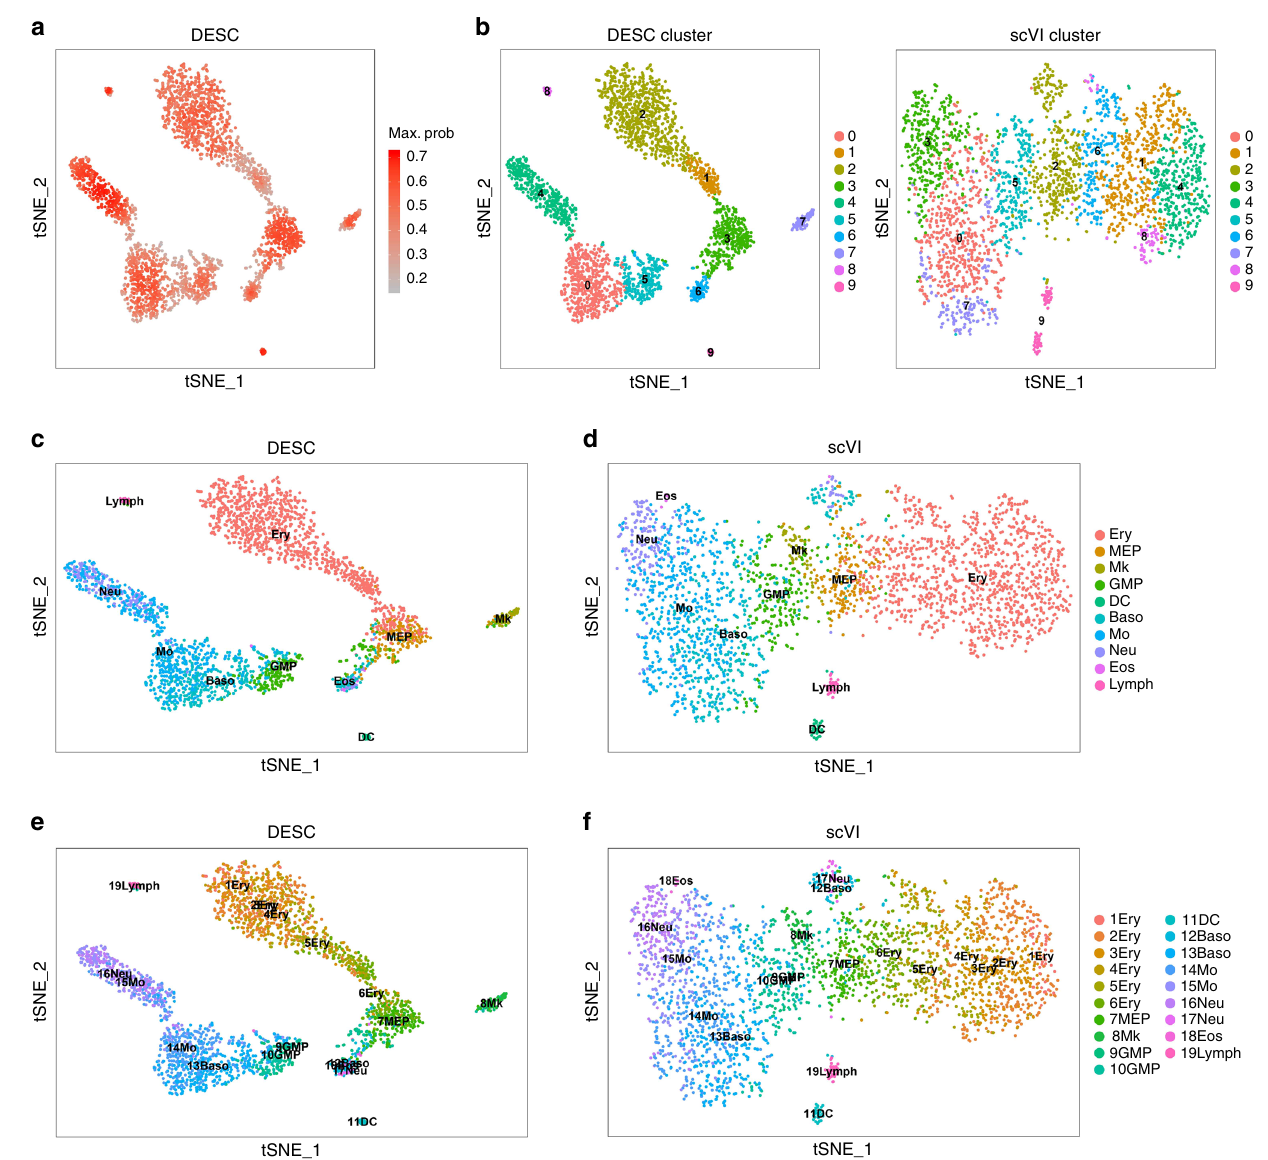
Fig. 6 The results of mouse bone marrow data generated by Paul et al. 21 . a The t-SNE plot showing the maximum probabilities of cluster assignments of cells. The maximum probability is the probability for the cluster that is assigned with the highest probability by DESC. b The t-SNE plots of clustering results by DESC and scVI. Compared with scVI, DESC yields more accurate clustering result for DC, lymph, and Mk. In scVI, the clustering result is more diffused, and Mk cells are mixed together with GMP cells. In contrast, DESC clearly separated DC, Lymph, and Mk cells from the other cell clusters. c , d The t-SNE plots of true cell-type labels (obtained from the original publication) for DESC and scVI. e , f The t-SNE plots of true cell-type labels with pseudotime ordering (obtained from the original publication) for DESC and scVI. Ery erythrocyte, MEP megakaryocyte/erythrocyte progenitors, Mk megakaryocyte, GMP granulocyte/macrophage progenitors, DC dendritic cell, Baso basophils, Mo monocyte, Neu neutrophils, Eos eosinophils; Lymph structure of the cells. DESC also identi fi ed discrete clusters in which fully differentiated cells such as dendritic cells, lympho- cytes, and megakaryocytes (Mk) are well separated from cells that are still under differentiation. Interestingly, in the maximum probability plot (Fig. 6a), cells that are differentiating have rela- tively lower probabilities than those that are fully differentiated, suggesting that the maximum probabilities are biologically interpretable. These results indicate that DESC is able to retain both discrete and pseudotemporal structure of the cells, making it applicable to a wider range of data. In contrast, clustering result from scVI is more diffused, and Mk cells are mixed with gran- ulocyte/macrophage progenitors (GMP), although Mk cells have distinct transcriptional pro fi les from GMPs 21 (Fig. 6b, d, f).